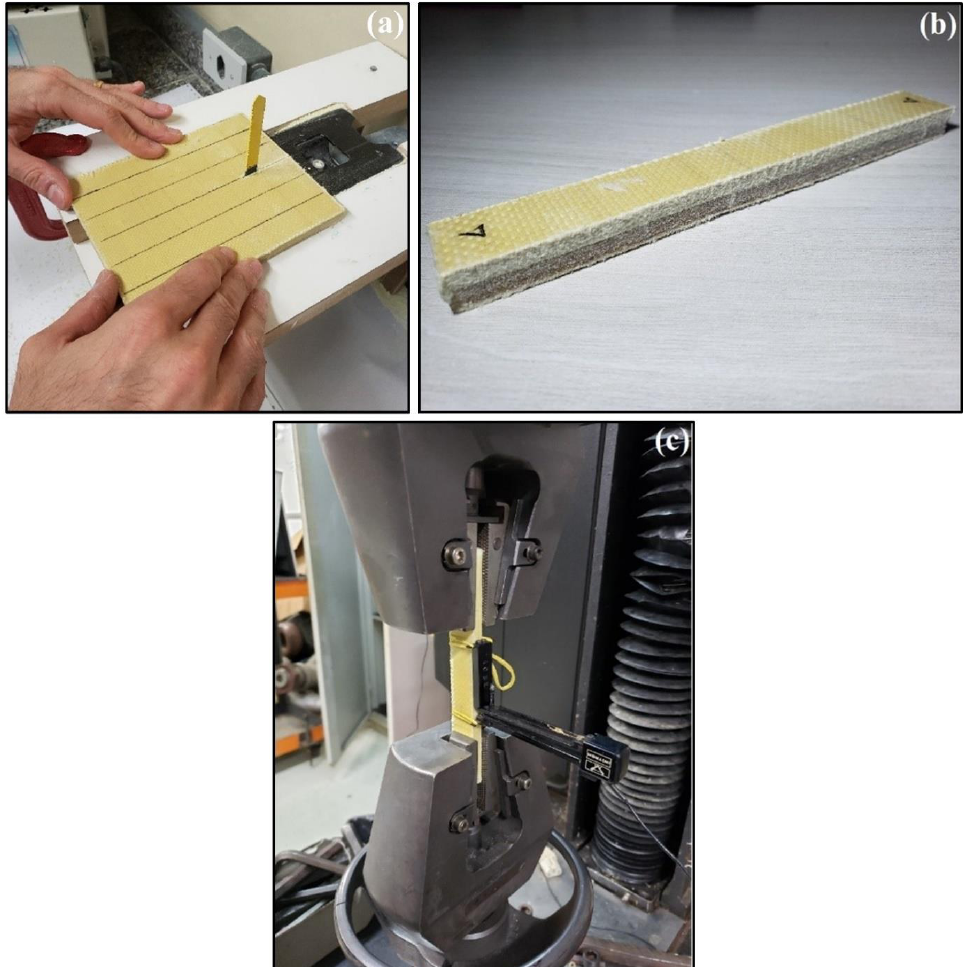
Figure 4. ( a ) Tensile test specimens cutting; ( b ) tensile test specimens ready; and ( c ) composite spec- imen tensile being